Question: What type of chart is this?
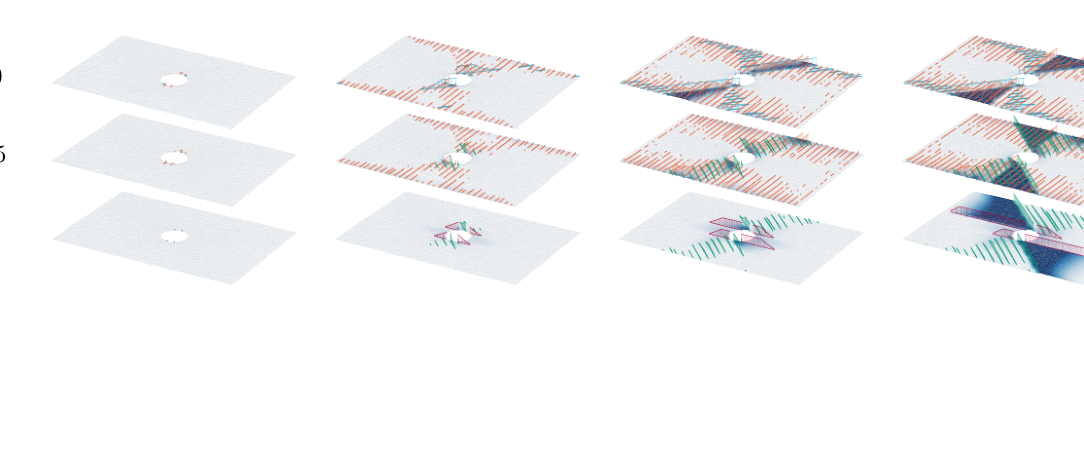
Answer: line